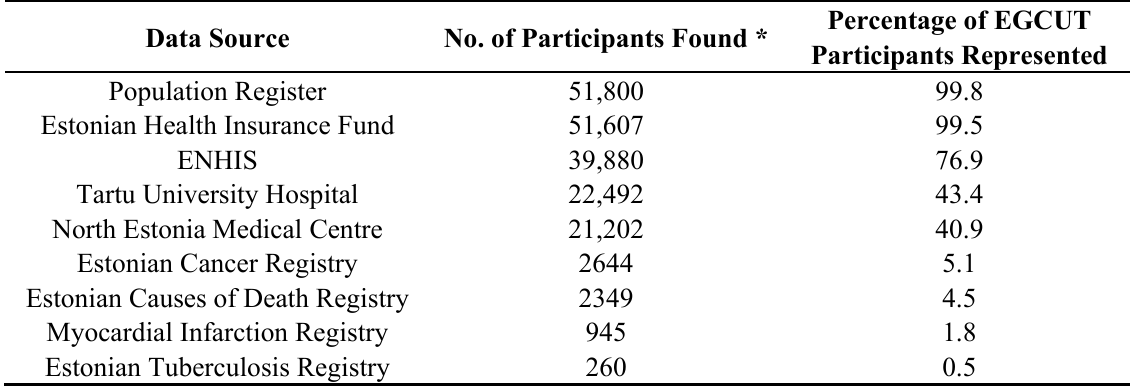
Table 1. Proportion of Estonian Genome Center of the University of Tartu (EGCUT) participants’ represented per data